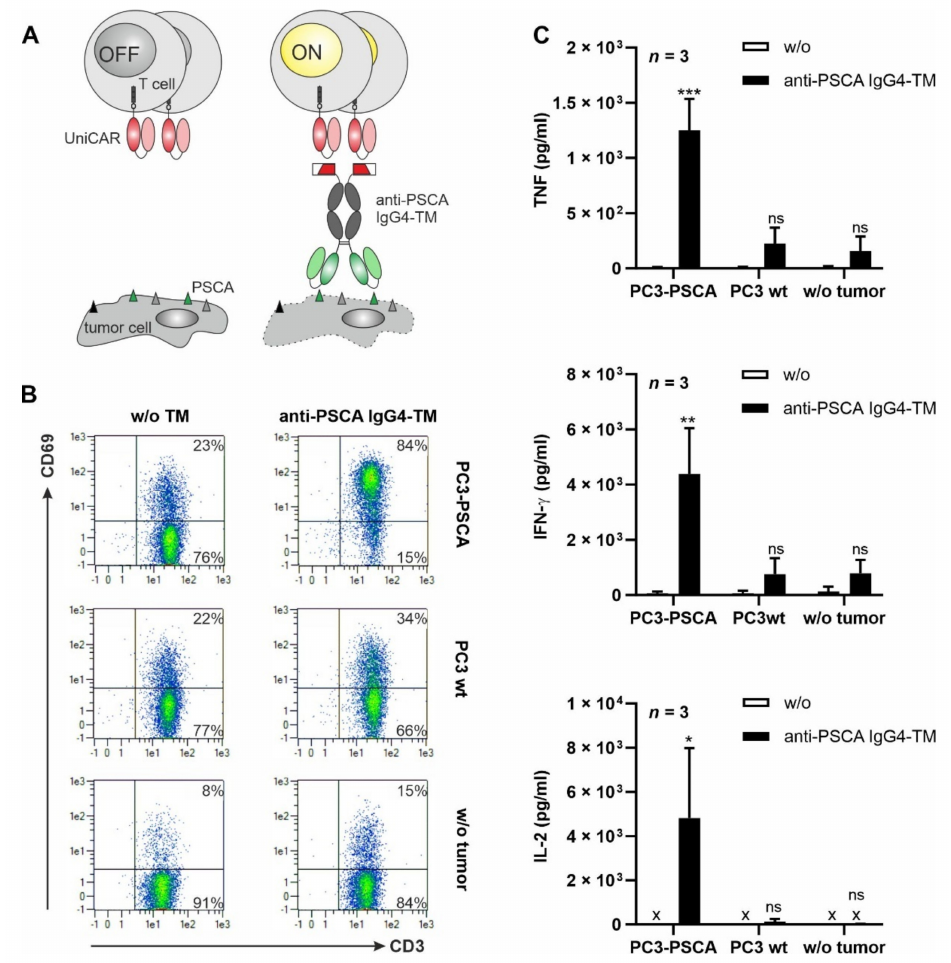
Figure 3. TM-mediated cross-linkage with tumor cells results in UniCAR T cell activation and cytokine release. ( A ) In the UniCAR T cell approach, T cells are engineered to express a universal chimeric antigen receptor (UniCAR) that recognizes the E5B9 peptide of the nuclear antigen La/SS-B. Thus, under physiological conditions UniCAR T cells are switched “OFF”. To engage the killing capabilities of UniCAR T cells against tumor cells (“ON”), an E5B9-tagged target module (TM) recognizing a tumor-associated antigen is required. ( B , C ) UniCAR T cells were incubated alone or with PC3-PSCA or PC3 wt cells at an E:T ratio of 5:1 in the presence or absence of 5 nM anti-PSCA IgG4-TM. After 24 h, ( B ) CD69 expression on UniCAR T cells and ( C ) secretion of TNF, IFN- γ and IL-2 were examined via flow cytometry or ELISA (x: not detectable), respectively. ( B ) Data of one representative experiment with one T cell donor are shown. ( C ) Summarized data of three different T cell donors are shown as mean ± SEM. (* p < 0.05, ** p < 0.01, *** p < 0.001 compared to samples w/o the anti-PSCA IgG4-TM; two-way ANOVA with post-hoc Š í d á k’s multiple comparisons